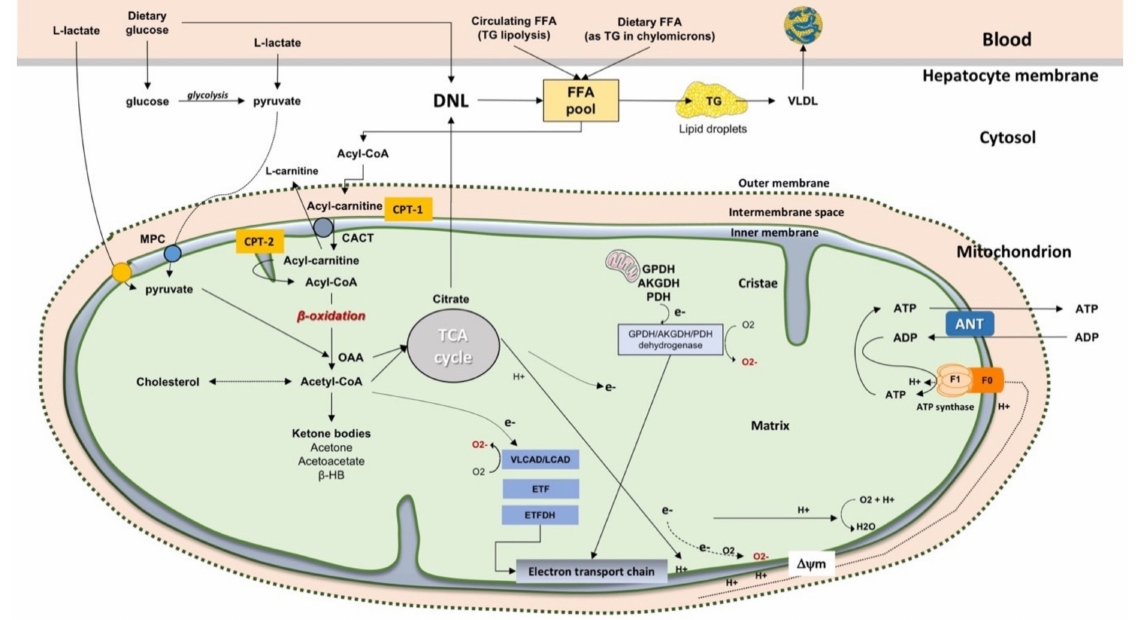
Figure 1. Mitochondrial function in the liver. Oxidative metabolism and hepatocyte energy homeostasis depend on FFA β - oxidation, the tricarboxylic acid cycle (TCA), electron flow along the electron transport chain, electrochemical proton gradient generation, and ATP synthesis. Ketone bodies are produced due to an absence of oxaloacetate used in gluconeogenesis (e.g., starvation and diabetes). Starting from blood, dietary glucose, dietary FFA (as TG within chylomicrons) and FFA circulating after TG lipolysis, enrich the FFA pool in the hepatocyte. During fatty acid synthesis, glucose from dietary sources during glycolysis is converted to pyruvate which can enter the mitochondrion via the mitochondrial pyruvate carrier (MPC). Pyruvate also can be synthesised from L-lactate after transport of L-lactate in the matrix, via its own carrier, and oxidation via the mitochondrial L-lactate dehydrogenase [19,20]. In the mitochondrial matrix, pyruvate provides acetyl-CoA via the pyruvate dehydrogenase complex and oxaloacetate (OAA) involving the pyruvate carboxylase. Due to citrate synthase, pyruvate and oxaloacetate give citrate which can be exported to allow for FFA synthesis is the cytoplasm in the de novo lipogenesis (DNL). Abbreviations: ACC, acetyl-CoA carboxylase (ACC); ANT, adenine nucleotide translocator; CACT, carnitine-Acylcarnitine Transferase; CPT-1, carnitine palmitoyltransferase-1; CPT-2, carnitine palmitoyltransferase-2; DNL, de novo lipogenesis; electron transfer flavoprotein (ETF); ETFDH, ETF dehydrogenase; FFA, free fatty acids; β -HB, β -hydroxybutyrate; MPC, mitochondrial pyruvate carrier; OAA, oxaloacetate; PEP, phosphoenolpyruvate; TG, triglycerides; VLDL, very low-density lipoprotein